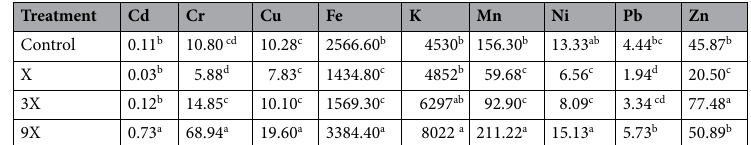
Table 4. Average heavy metals concentrations in root [ppm]. Means in the same column with similar superscripts are not statistically different (Duncan test, P ≤ 0.05).